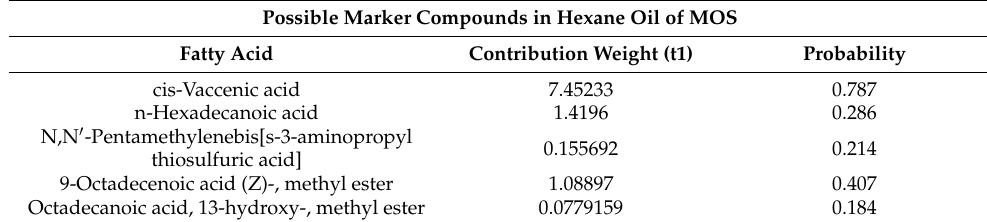
Table 4. Summary of Chemometric analysis of hexane extracted MOS